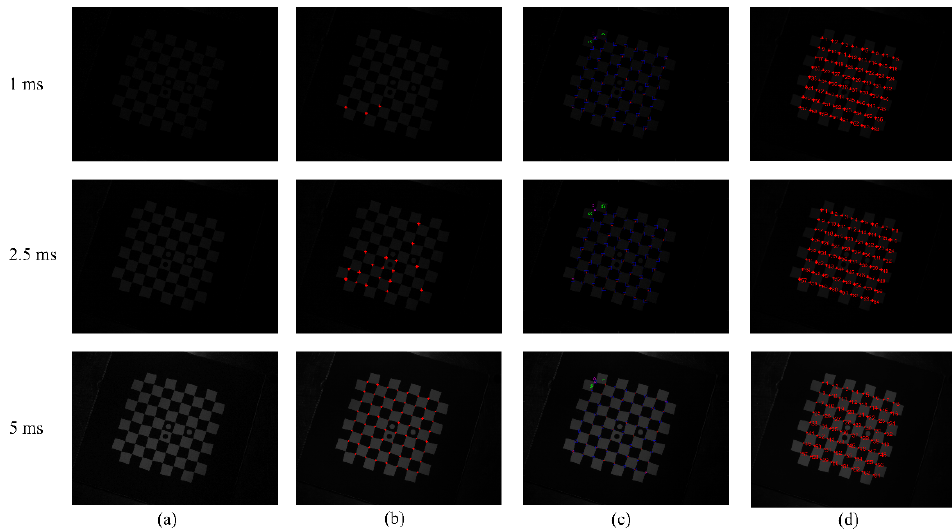
Figure 7. Comparison of corner-detection results in underexposure state: ( a ) original image, ( b ) corner-detection result of the literature [36] method, ( c ) corner-detection result of MATLAB Toolbox, and ( d ) corner-detection results of the method in this paper. Under different exposure times, the number of corner points detected by the three meth- ods is shown in Table